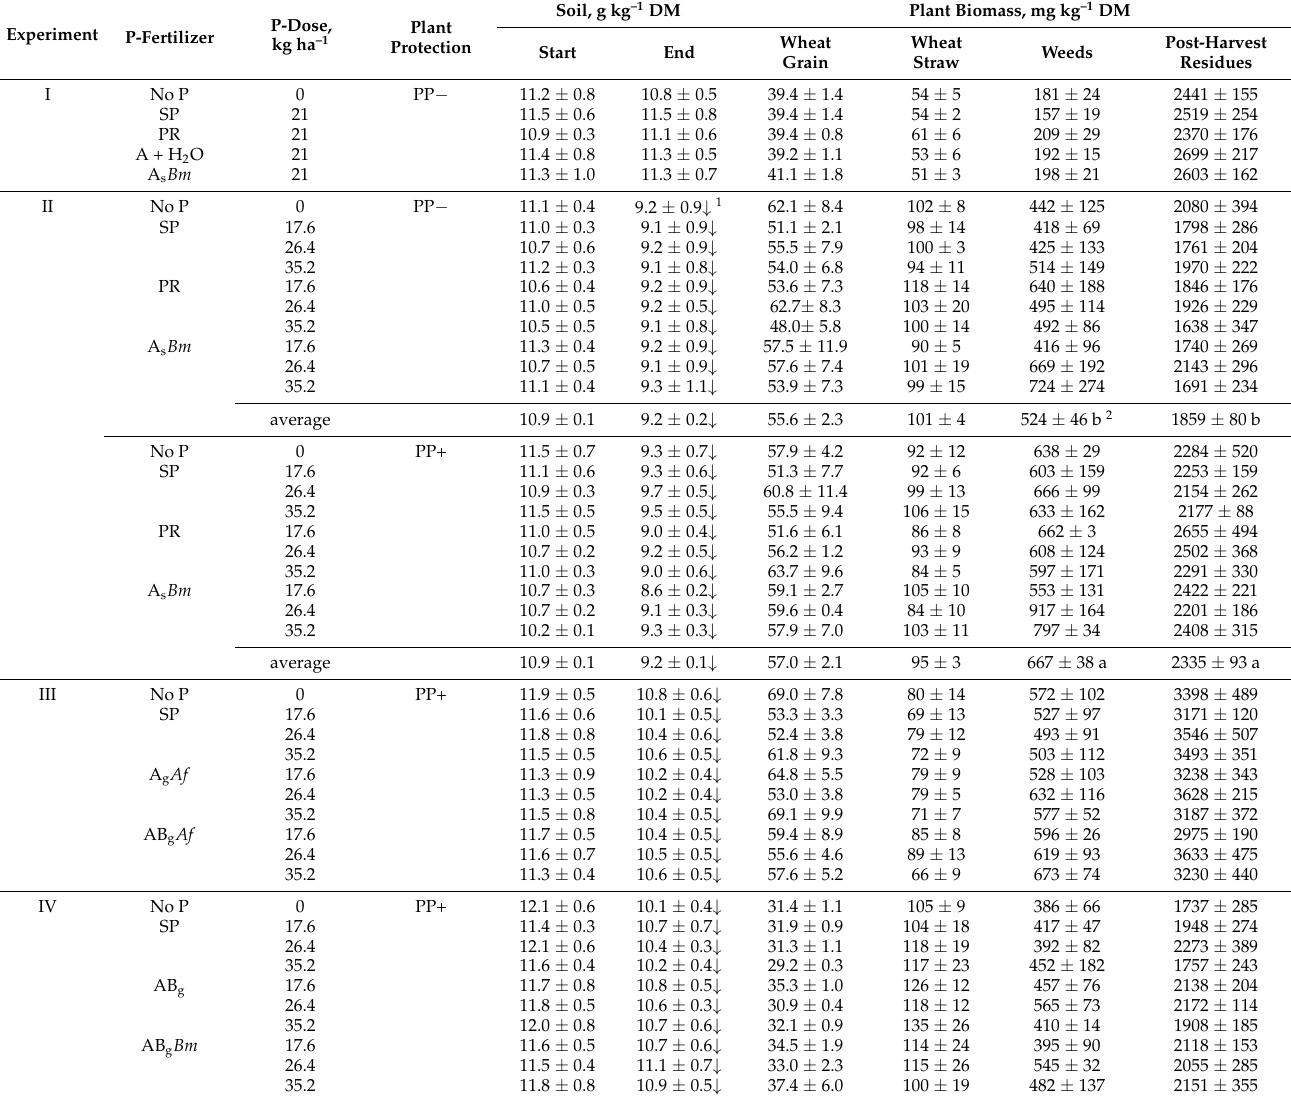
Table 3. Total Fe content in soil and plant biomass (average ± standard